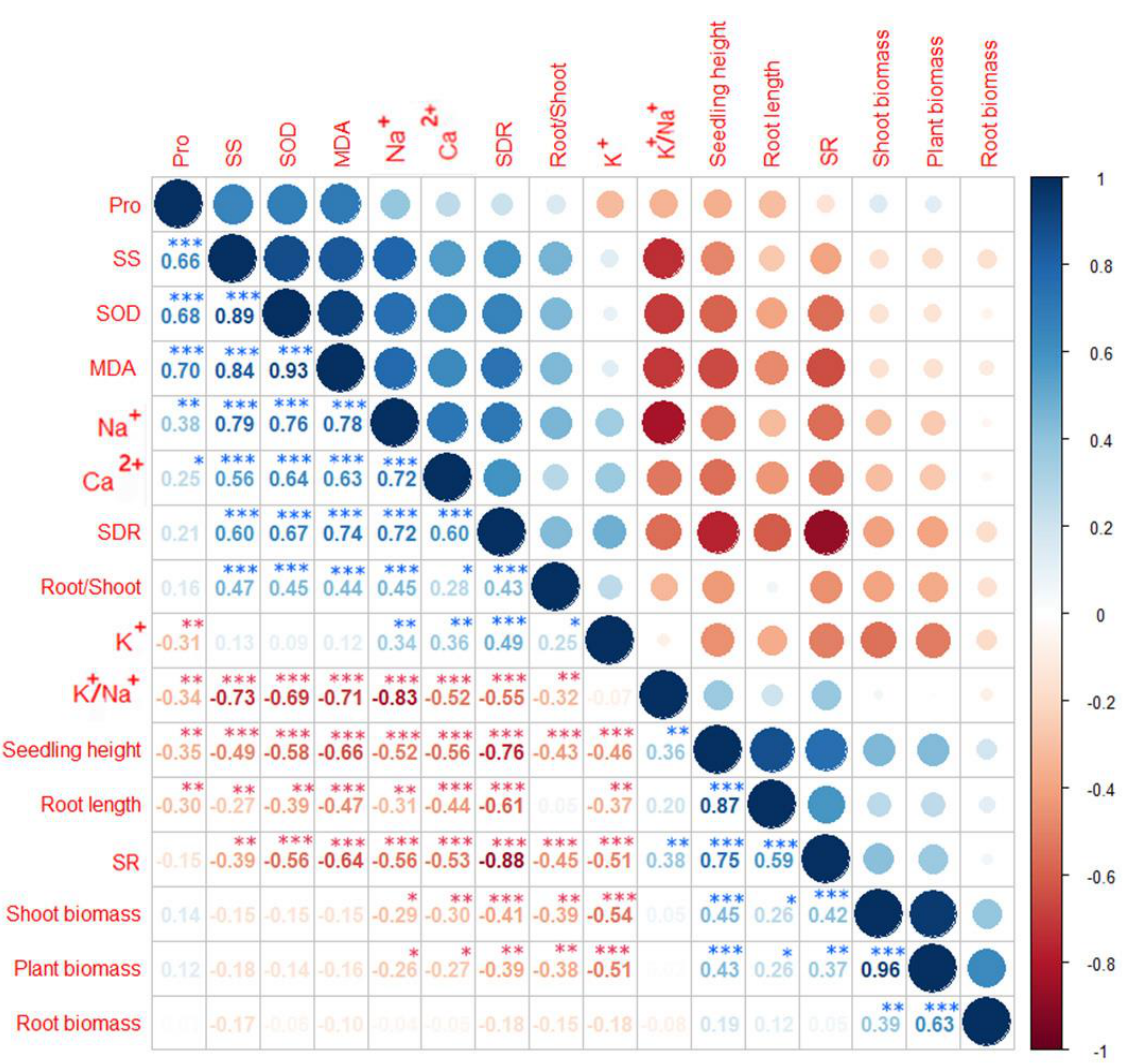
Figure 4. Correlation between seedling growth and physiological and biochemical parameters in seedlings of two dogwood species subjected to salt stress. Data in the boxes are the correlation coefficient. Red and blue represent positive and negative correlation, respectively. *, **, and ***: significant at the 0.05, 0.01, and 0.001 probability levels, respectively.